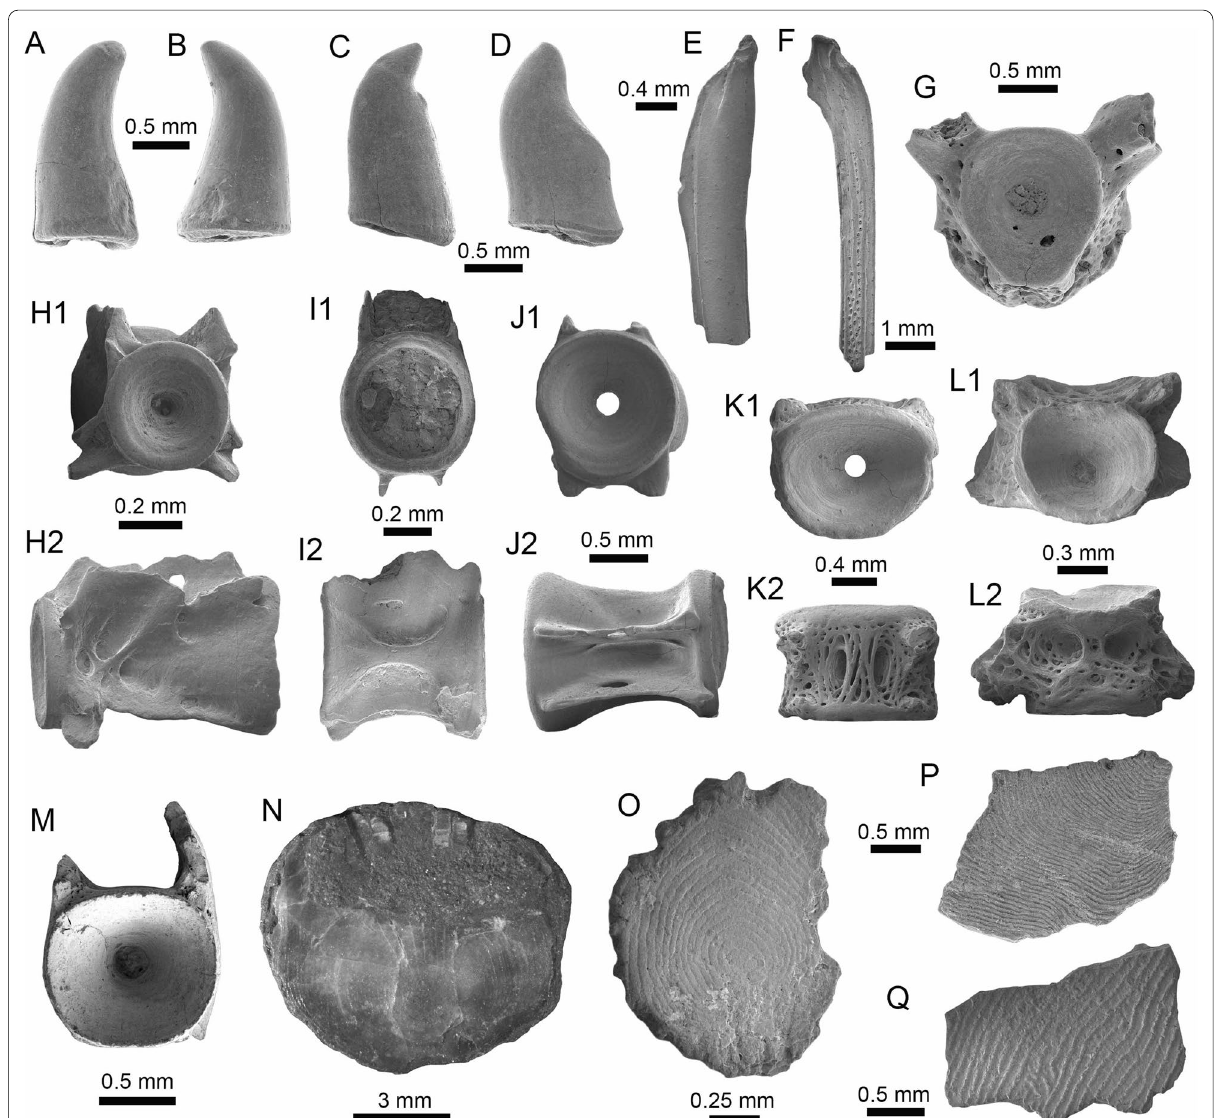
Fig. 13 Actinopterygii indet from the Vergel Member. A – D Pharyngeal ( C , D AMU‑CURS‑1145) and other teeth of indeterminate position ( A , B AMU‑CURS‑1178). E , F Ceratobranchial bones (AMU‑CURS‑1238). G – M Isolated vertebrae (AMU‑CURS‑1177). N – Q Isolated scales (AMU‑CURS‑863). Views: anterior ( G , H1 , I1 , J1 , K1 , L1 , M ), Dorsal ( J2 , K2 ), lateral ( A – D , H2 , I2 ), ventral ( L2 ), and indet. ( N – Q